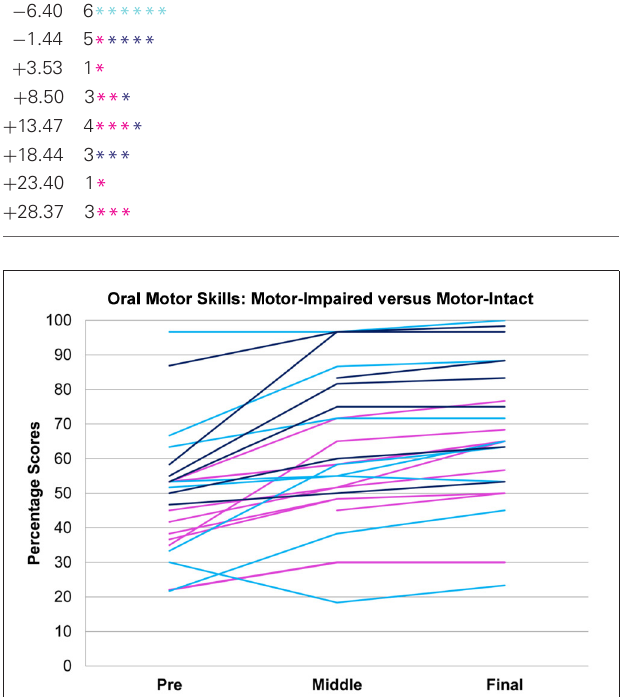
FIGURE 2 | Oral motor scores over time in motor-impaired (magenta) and motor-intact (blue) groups. Modulo a great deal of heterogeneity, the motor-impaired group on the whole began with lesser scores than the motor-intact group, by definition, but also ended with lesser scores. (For consistency with the other figures, the motor-intact group is color-coded separately as light blue for the receptive-impaired subgroup and dark blue for the receptive-intact).